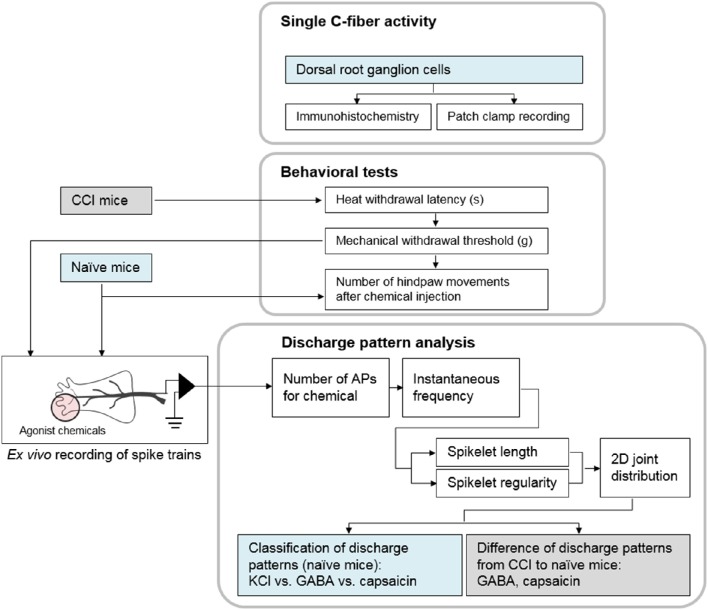
Block diagram of the experiments. First, we showed single C-fibers could be activated by three chemicals. Behavioral tests were followed to measure the evoked nociception after subcutaneous injection. Then, the discharge patterns in the spike trains from ex vivo recording were analyzed.